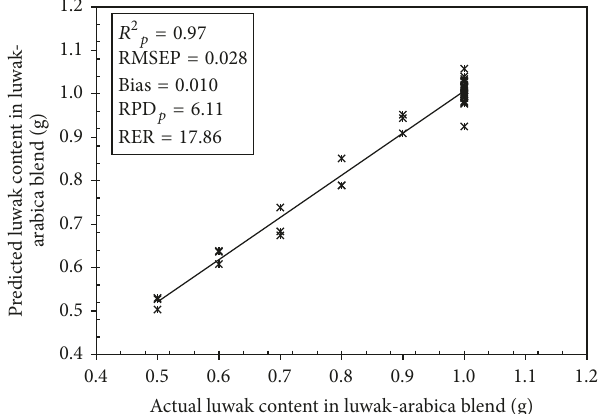
Figure 4: Scatter plot of actual versus predicted luwak content calculated using the best PLS calibration